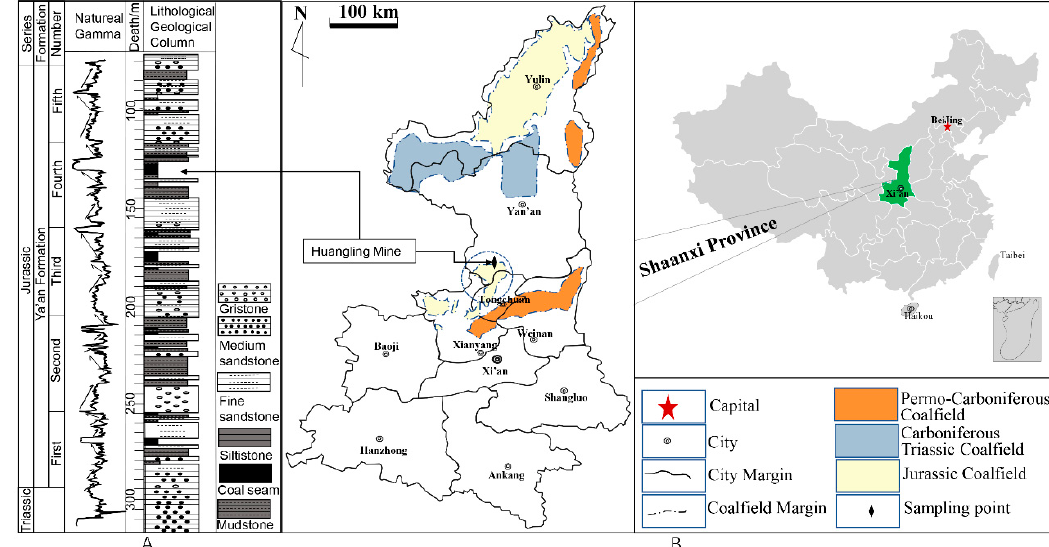
Figure 1. Sampling points and stratigraphic histogram [40]. ( A ) Stratigraphic histogram; ( B ) Sample points.